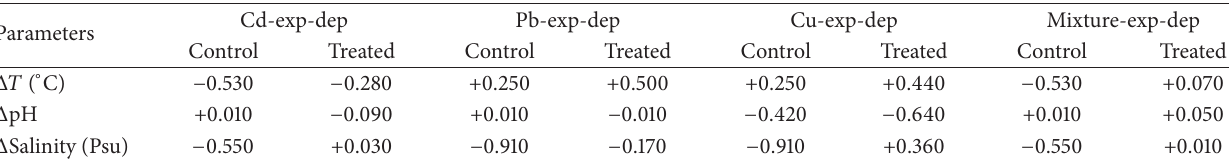
Table 4: Means of abiotic parameters in exposure-depuration tests (exp: exposure, dep: depuration, (+): augmentation, and ( − ):